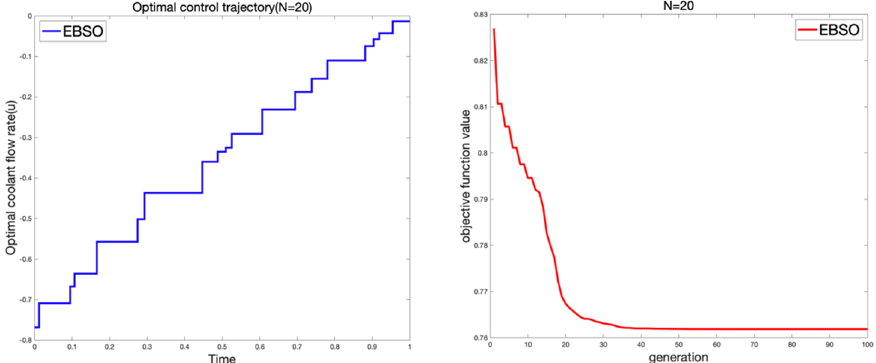
Figure 19. Optimal control trajectory and iteration curve ( 20 N = ).